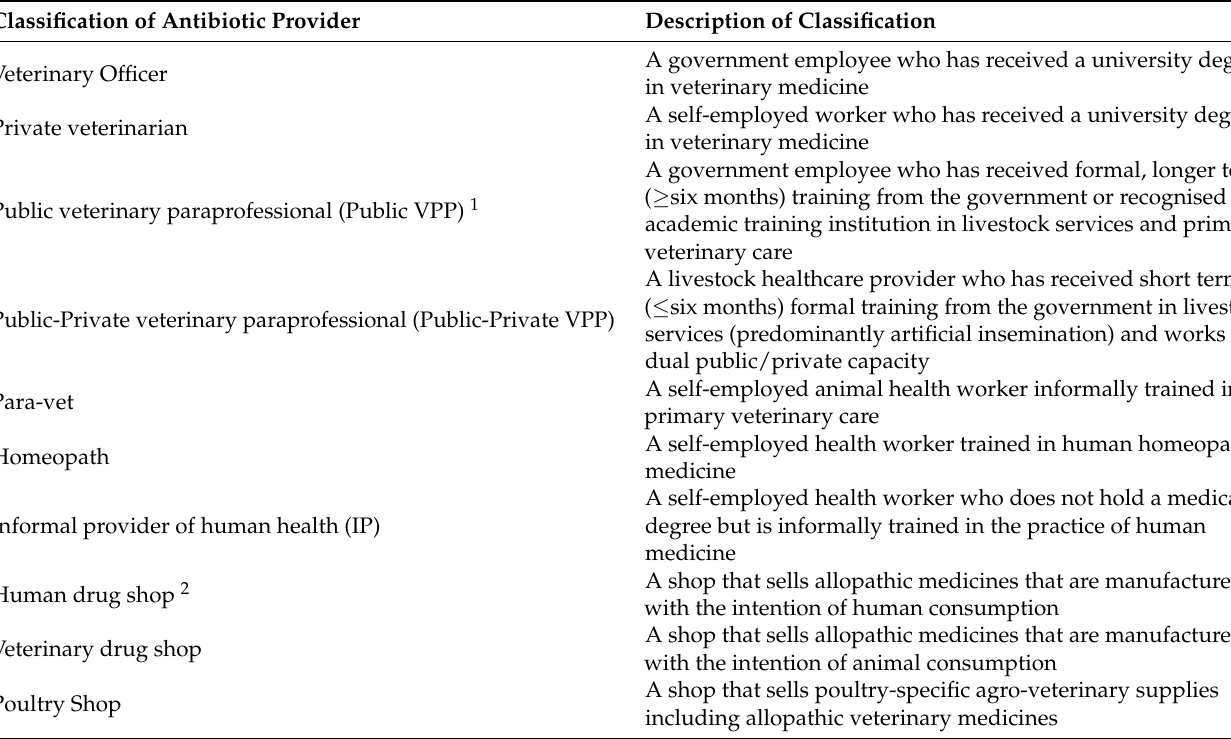
Table 2. Typology and description of the antibiotic providers in the study